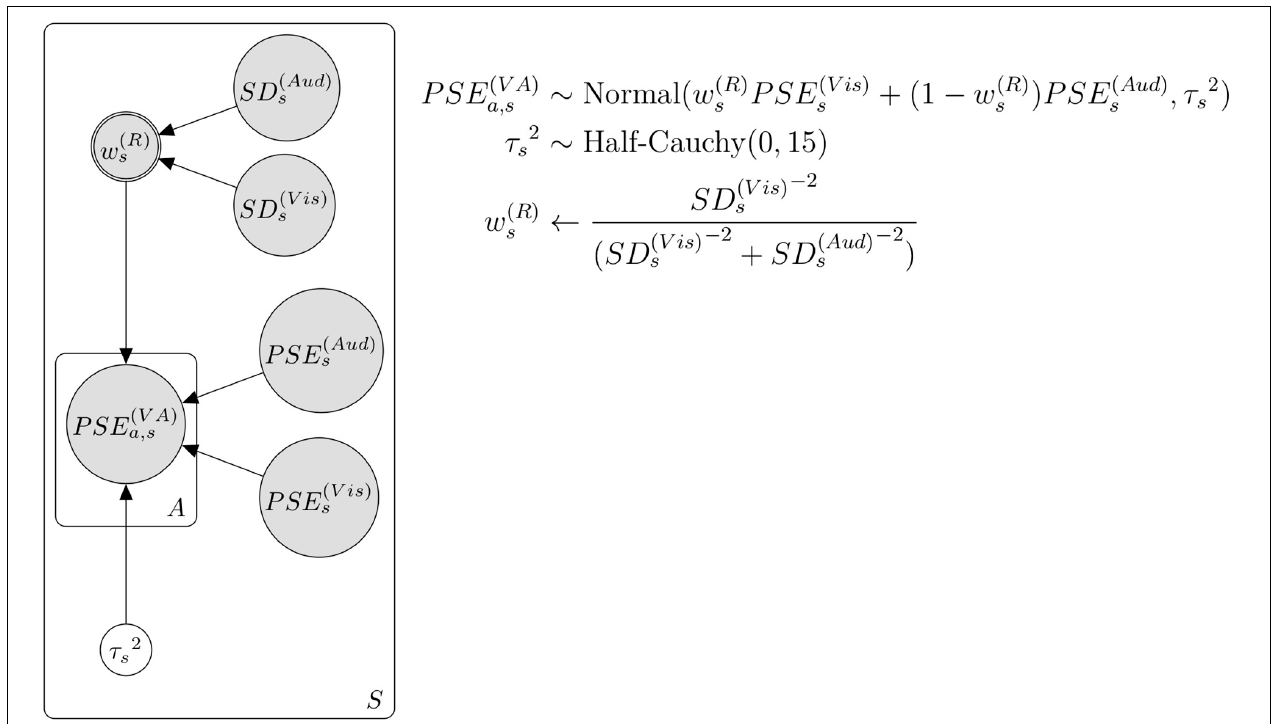
FIGURE 5 | Bayesian hierarchical model with the weight by reliability. A and a represent each attention condition. S and s represent each subject.